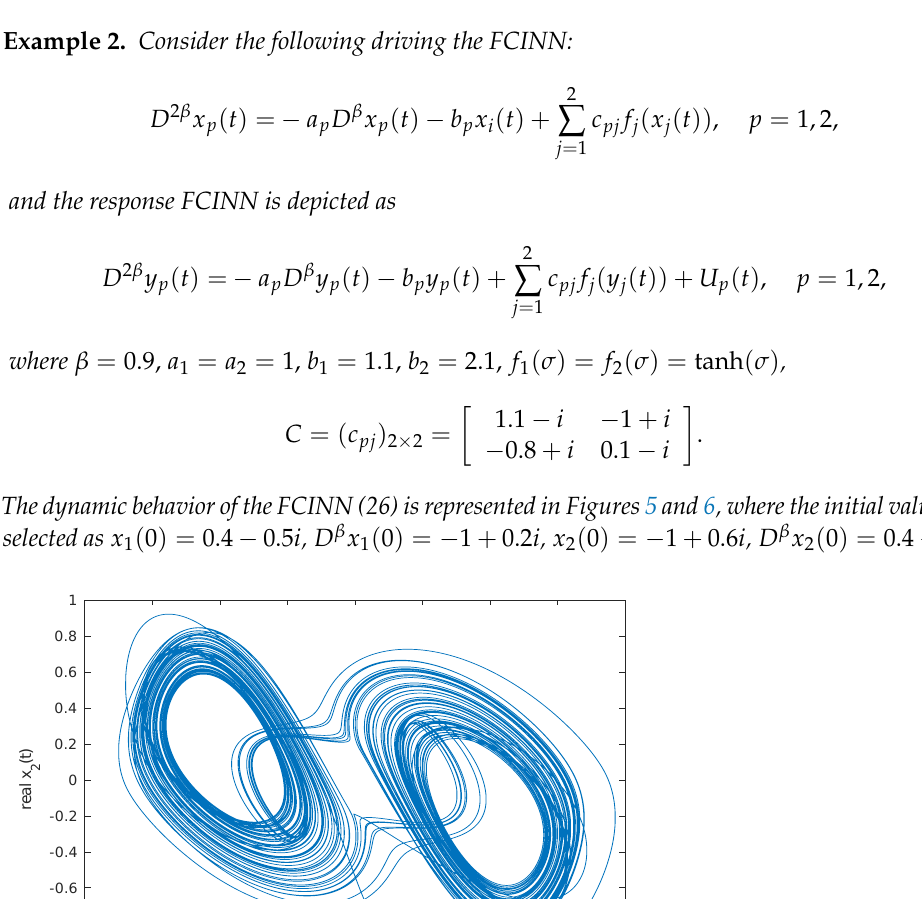
Figure 4. Dynamic evolution of the imaginary part of the FCINN (26) with I 1 ( t ) = 5sin ( 2 t ) + i 5sin ( 2 t ) and I 2 ( t ) = 5cos ( 2 t ) + 5 i cos ( 2 t ) .